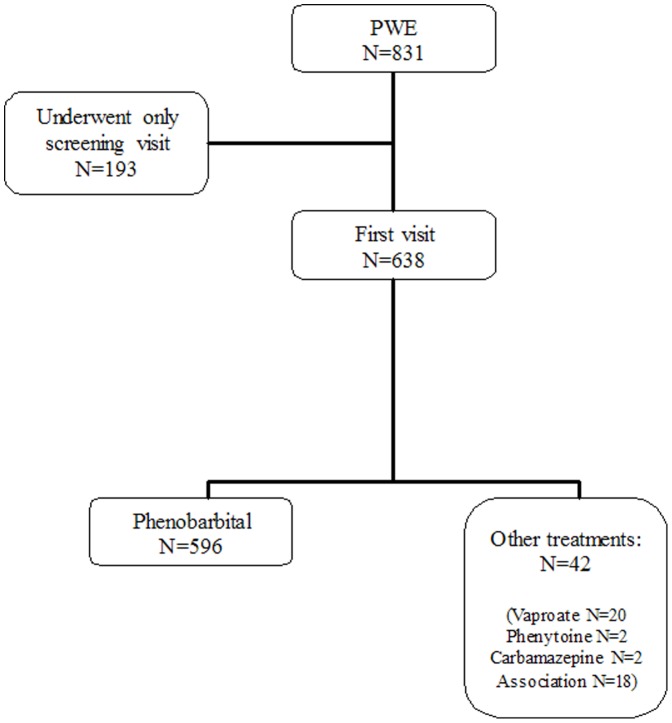
Patients enrollment and treatments underwent.